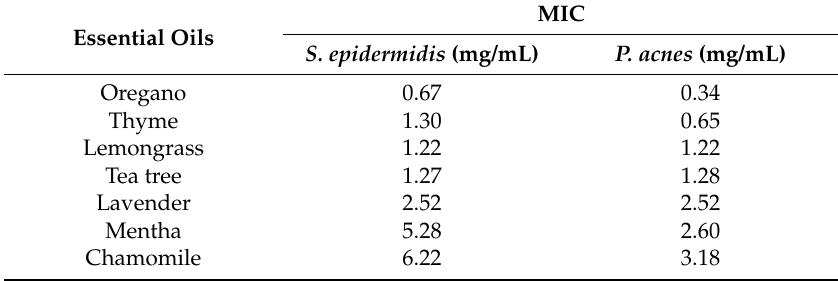
Table 1. Minimal inhibitory concentration (MIC) of the seven tested EOs against S. epidermidis and P. acnes .